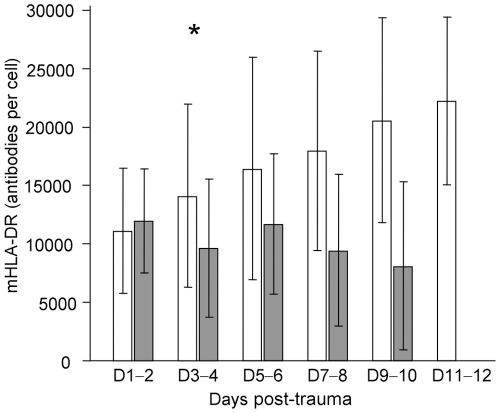
Time course of mHLA-DR expression in trauma patients, with (gray) or without (white bars) sepsis.mHLA-DR is expressed as numbers of anti-HLA-DR antibodies bound per cell (AB/C). Results are expressed as mean ± standard deviation (t test, * p<.01). mHLA-DR expression was not different between the two groups at days 1–2, but was significantly lower in septic patients than in non-septic patients at days 3–4.